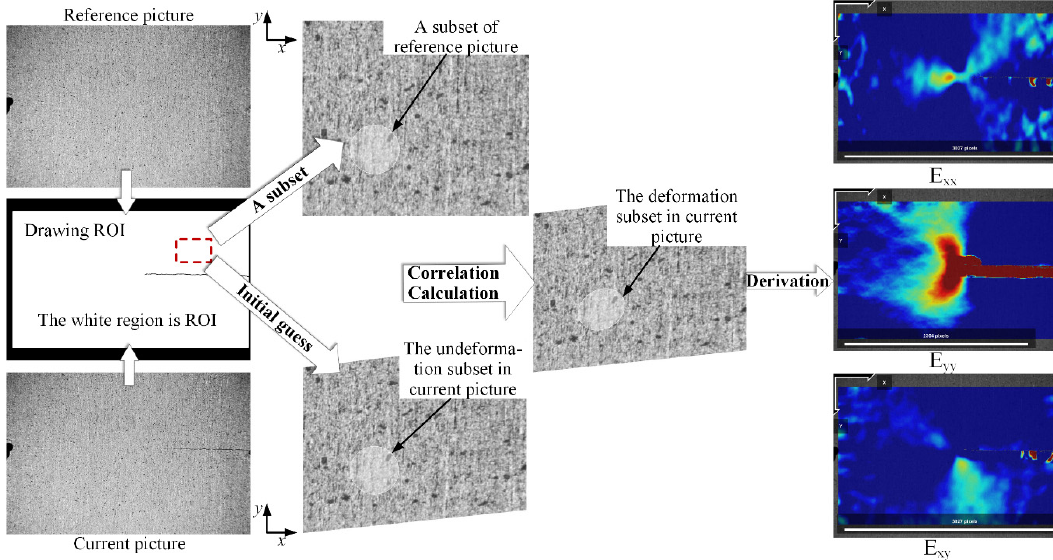
Figure 1. Principle of the digital image correlation (DIC) method used for in-plane strain mapping.